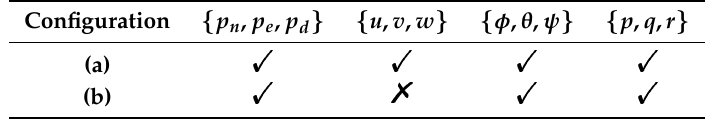
Table 1. Sets of measurements from which the full rank matrix condition ( rank ( OOO ) = dim ( x ) ) is accomplished.